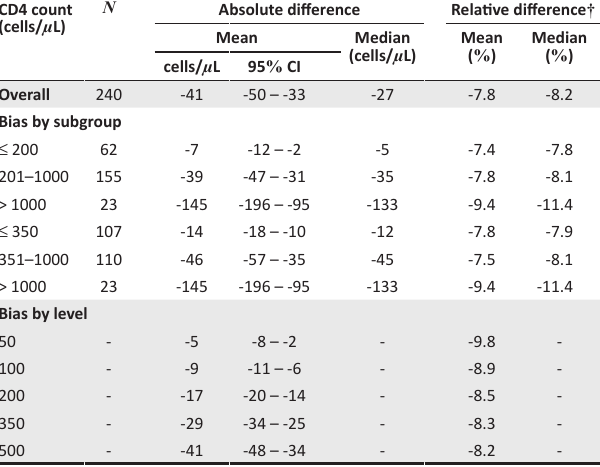
TABLE 1: CD4 count absolute and relative bias between AQUIOS PanLeucogating and Flowcare PanLeucogating overall, by CD4 subgroup and at clinically relevant CD4 levels , Canada; Paris, France; Lyon, France; and South Africa, November 2014 to March 2015.